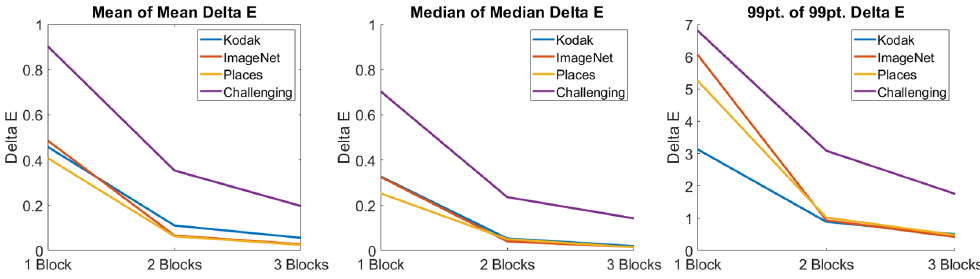
Figure 7. Change in ∆ E as the number of blocks in the CLHE TM-Net increases. Left, mean of mean ∆ E. Middle, median of median ∆ E. Right, 99-percentile of 99-percentile ∆